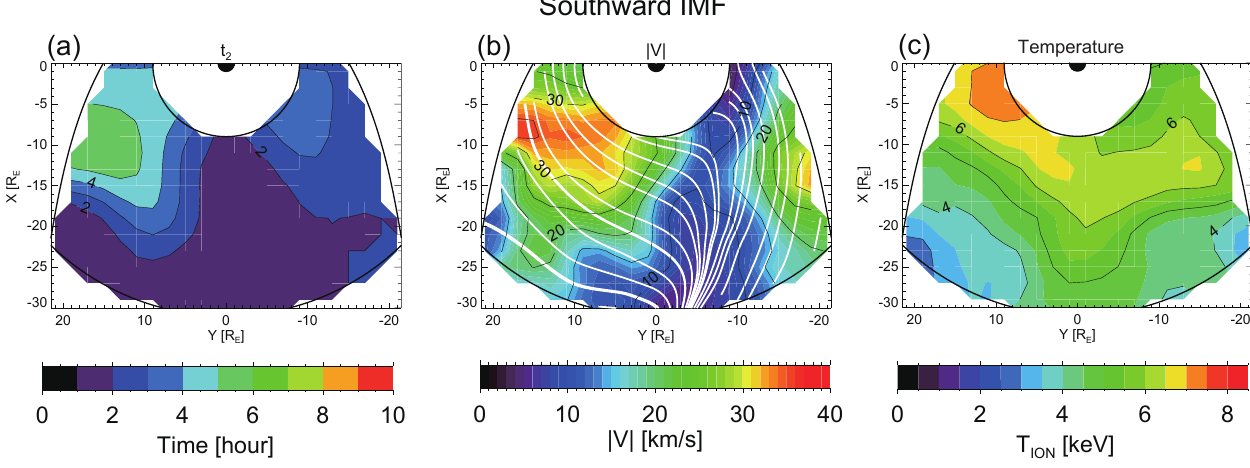
Fig. 15. (a) Equatorial distribution of IMF B z effect time lag for southward IMF. (b) Equatorial distribution of ion flow velocity. Stream lines are shown in white curves. (c) Distribution of average ion